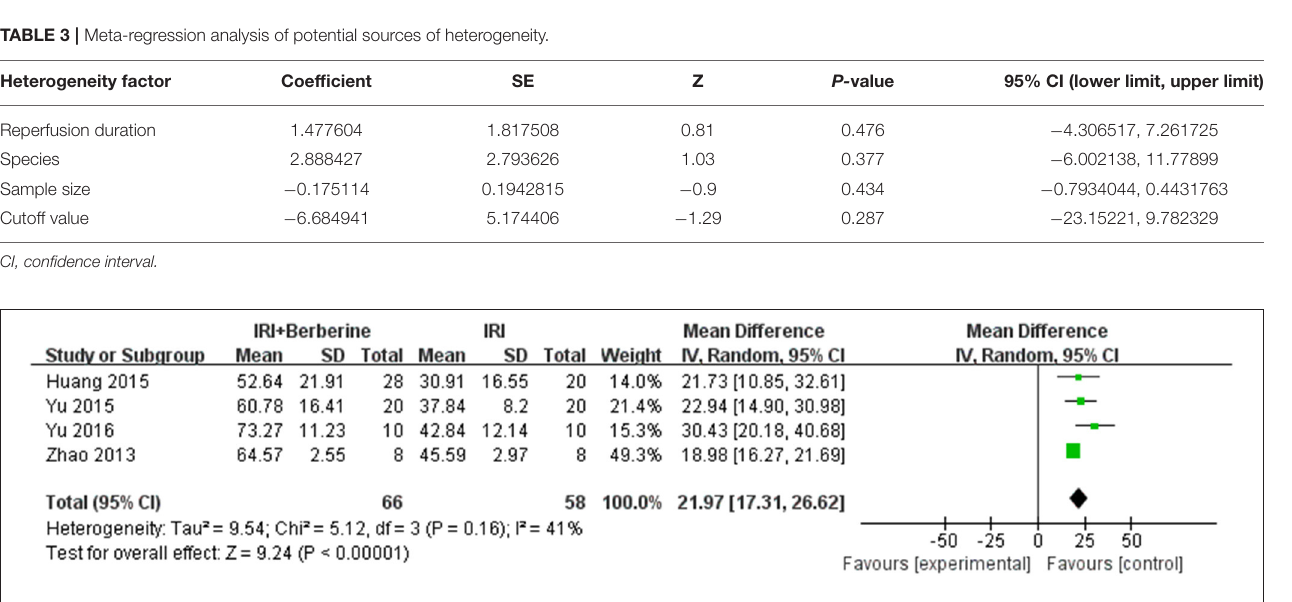
FIGURE 4 | Funnel plot showing BBR vs. control group regarding myocardial infarction size.